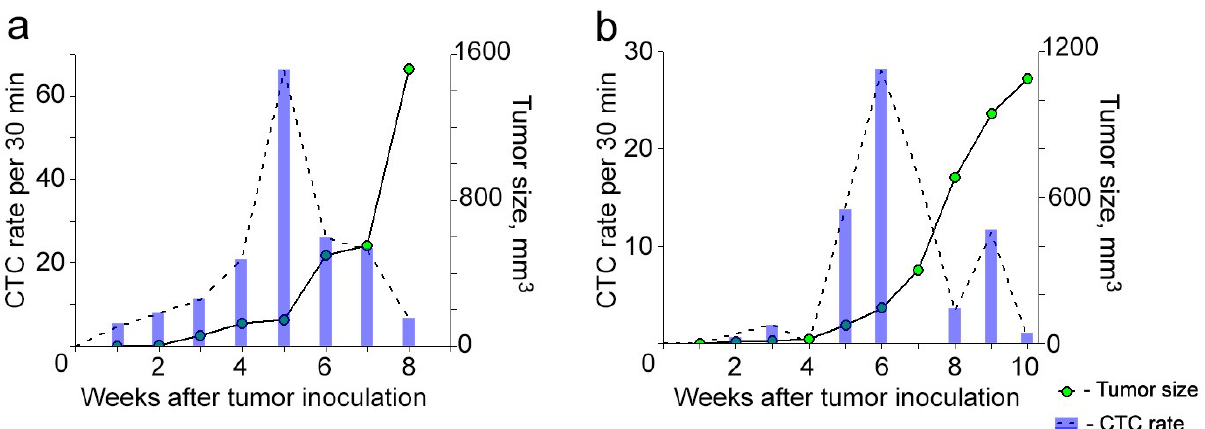
Figure 2. Correlation of CTC kinetics with tumor growth in breast cancer based on FFC data and whole body imaging, respectively. ( a ) Individualized CTC dynamics maximize before the primary tumor starts progressively growing; ( b ) Individualized CTC dynamics with two peaks. Tumor volume was calculated by formula: ½ × long diameter × short diameter 2